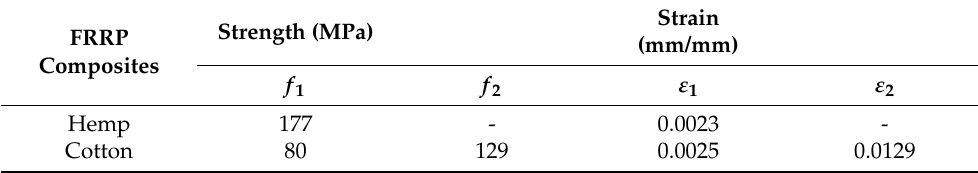
Figure 6. Typical stress-strain curves of FRRP composites ( a ) hemp and ( b ) cotton. Table 5. Mechanical properties of NFRRP composites.